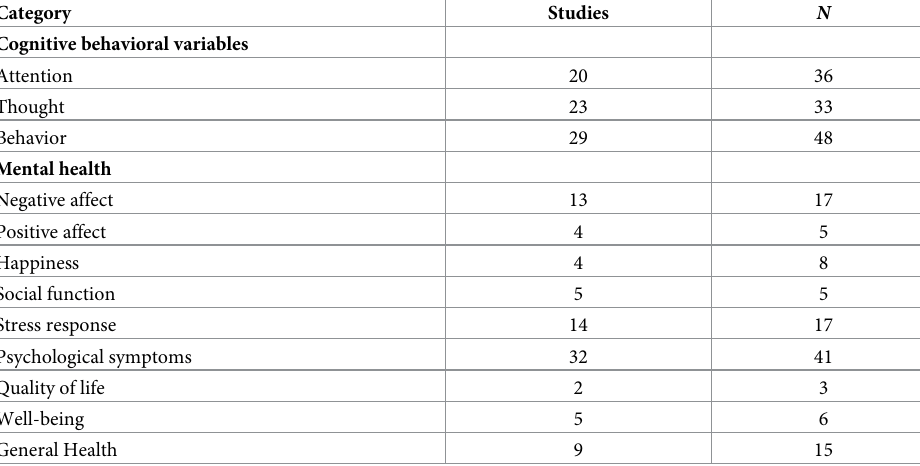
Table 2. Classification of the included